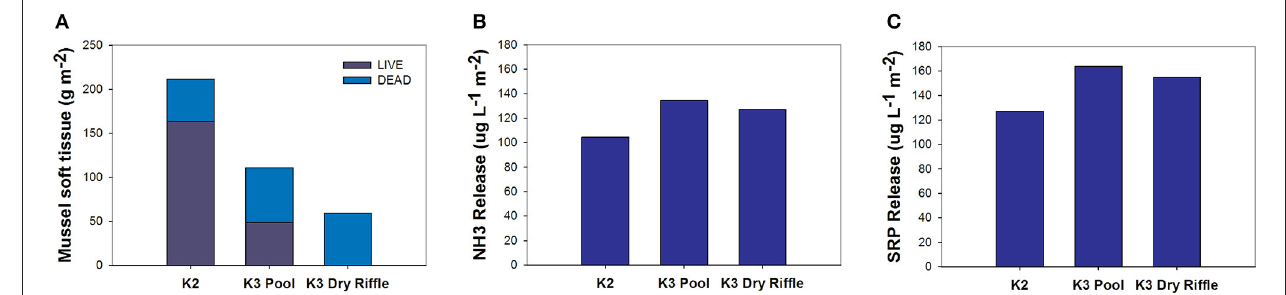
FIGURE 5 | Extrapolated nutrient release from Kiamichi mussel beds after a drought-induced mass mortality event. The shell lengths from dead unionids are used to predict mussel soft tissue (A) , which was then paired with nutrient data from the mesocosm experiment to predict ammonium release ( µ g m − 2 ; B ) and SRP release ( µ g m − 2 ; C ).